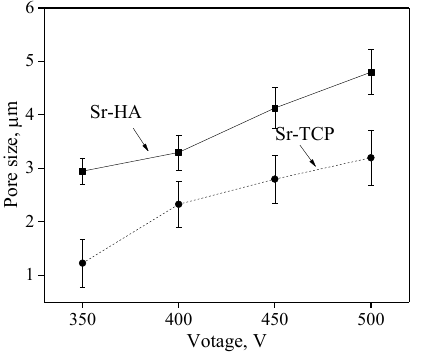
Figure 3. Graphs of the pore sizes against the applied voltage for Sr-HA and Sr-TCP coatings.